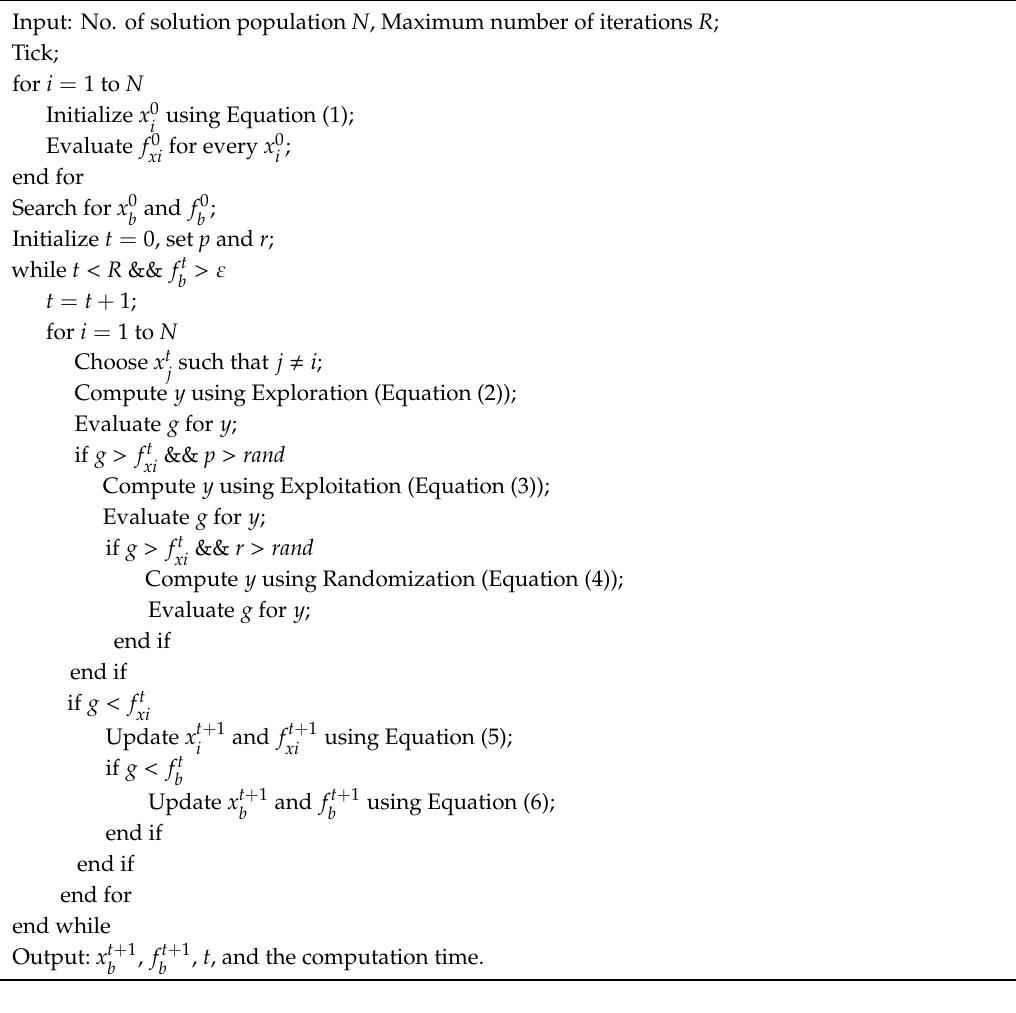
Algorithm 1: Fine-Tuning Meta-Heuristic